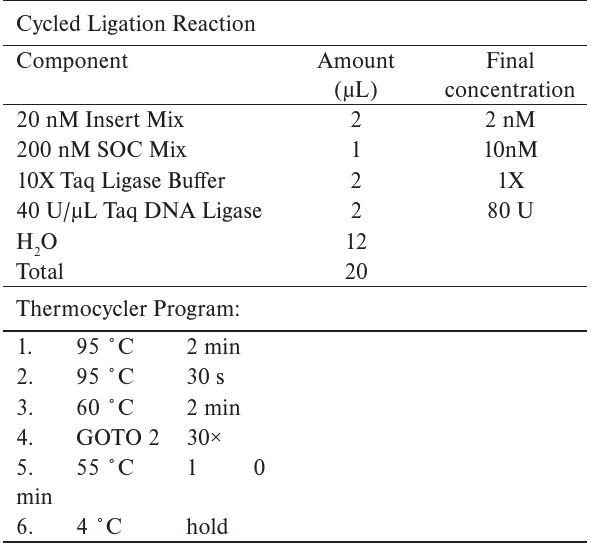
Table 2. CLA reaction setup and thermocycler program 7